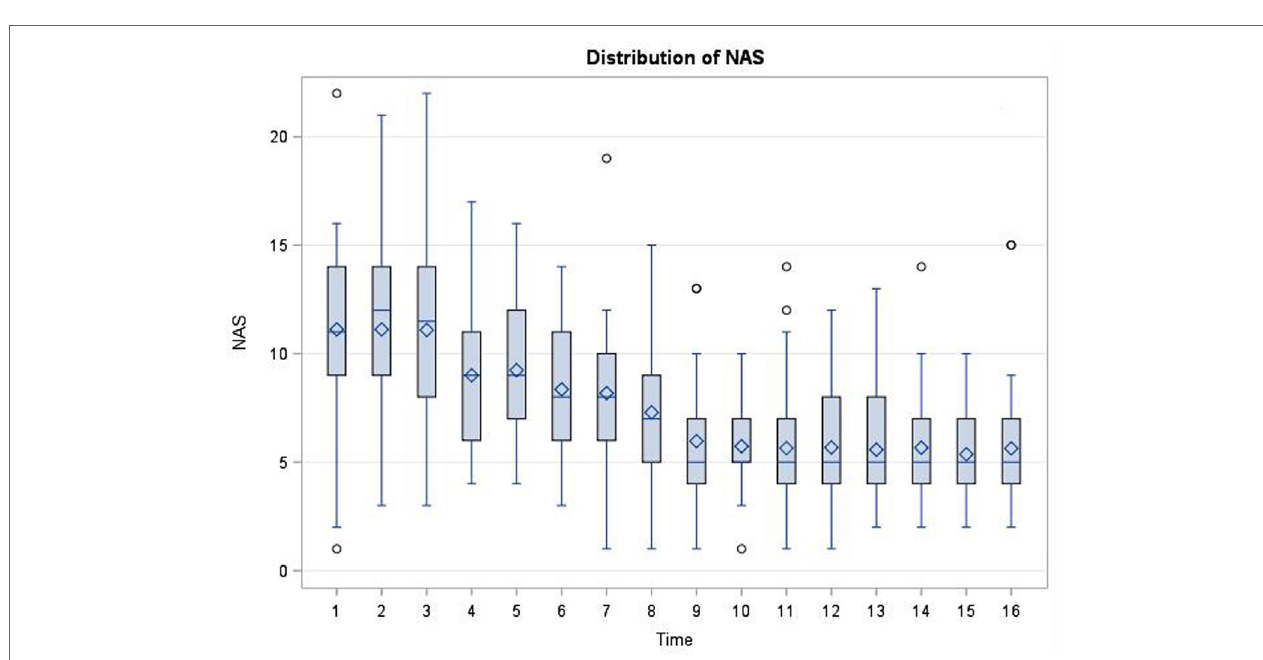
FigUre 3 | Distribution of neonatal abstinence syndrome (NAS) scores at each time point (every 3 h, total of 16 time points) in the first 48 h after admission for NAS. The scores significantly changed over time based on Friedman Test ( p < 0.0001).